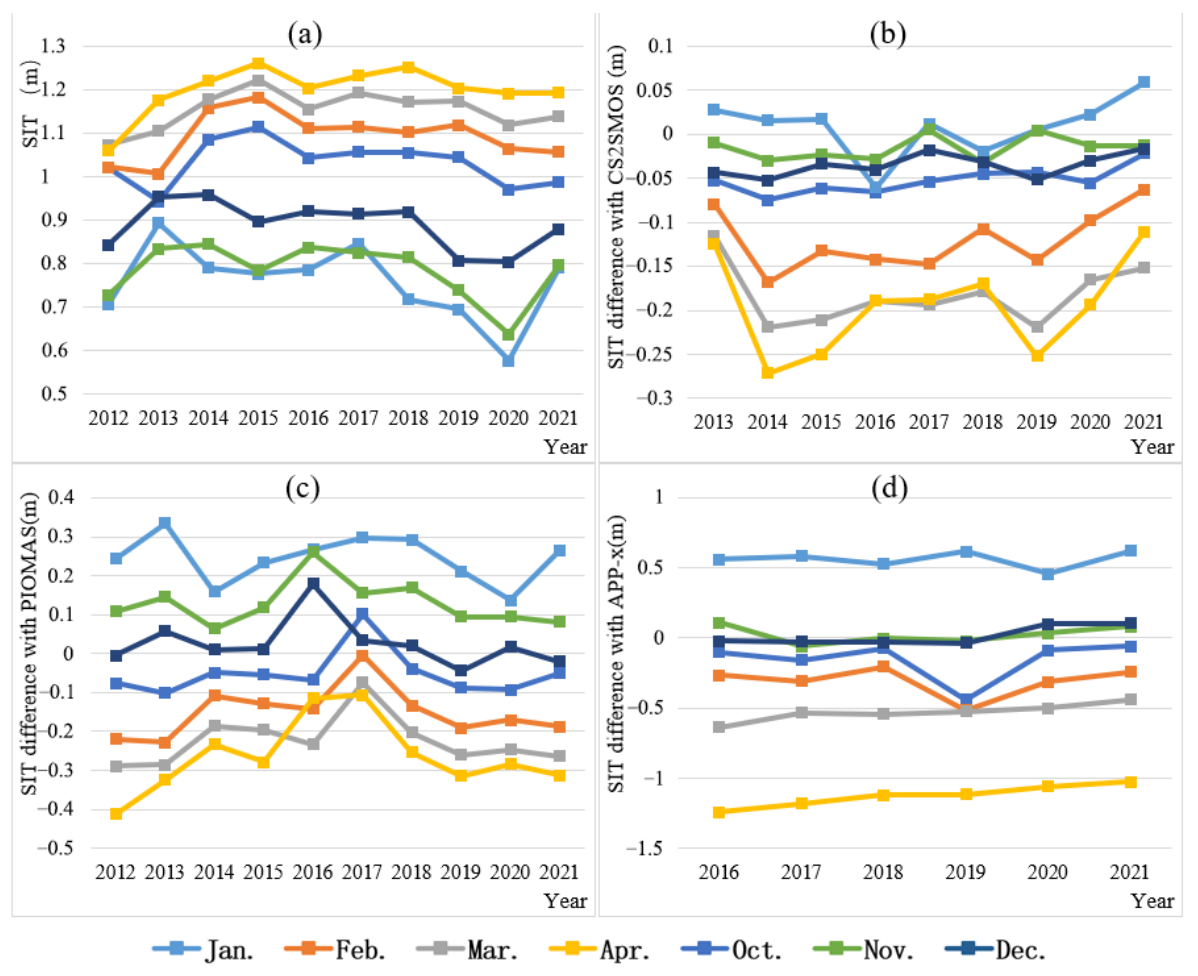
Figure 8. Interannual variations in Arctic sea ice thickness between 2012 and 2021, along with a comparison to various products. ( a ) The interannual variation of monthly mean SIT obtained by SAC-Net; ( b ), ( c ), and ( d ) depict the differences between monthly average SIT obtained by SAC-Net and those obtained by CS2SMOS, PIOMAS, and APP-x, respectively.